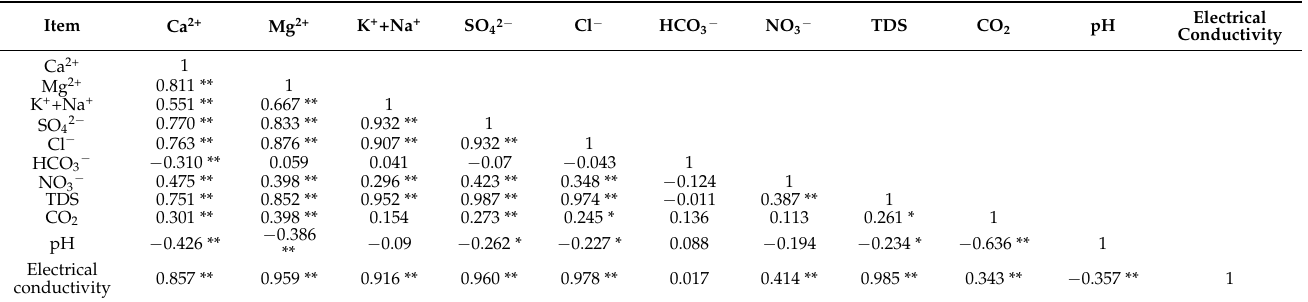
Table 1. Correlation coefficients between different chemical parameters in the study area.